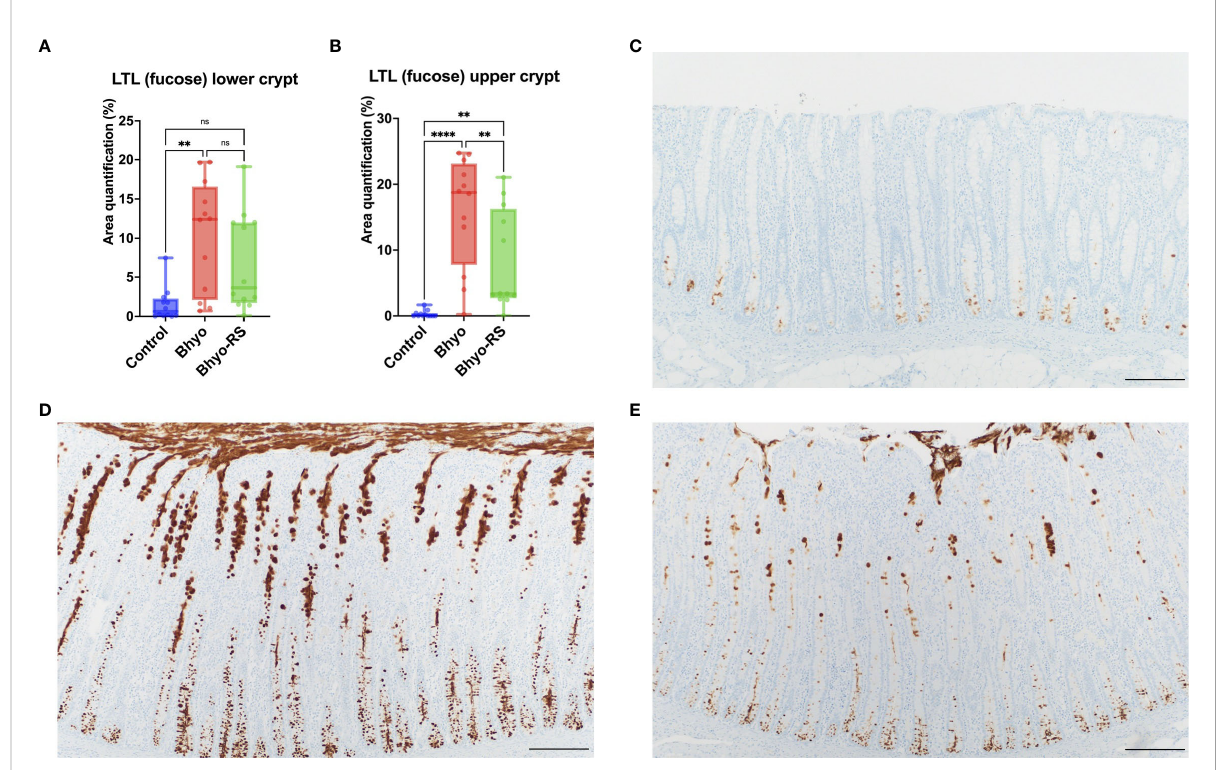
FIGURE 2 Staining intensity of LTL targeting a -linked L-fucose was signi fi cantly different between the three groups (A, B) and was low in the control (C) . Pigs from the Bhyo group (D , P < 0.05) had higher intensity of LTL throughout the full thickness of the mucosa compared to the controls (C) , and the Bhyo-RS group had a higher staining intensity tendency in the lower mucosa (A , P = 0.065) and signi fi cantly higher staining intensity in the upper colonic mucosa compared to the controls ( B, E P < 0.05). Bar = 200 µm. **, P ≤ 0.01; ****, P ≤ 0.0001; ns, not signi fi